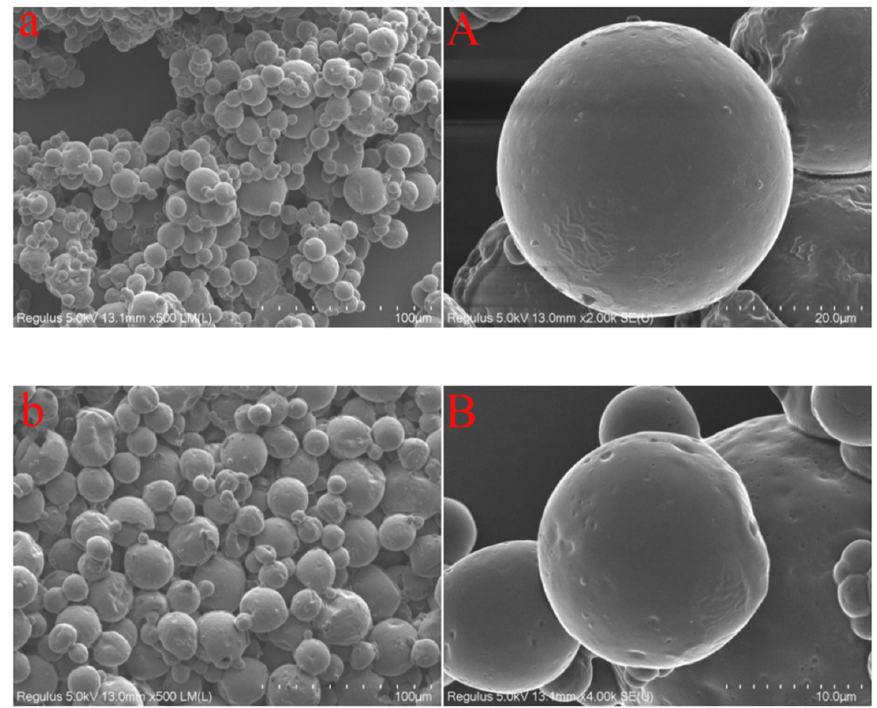
Figure 7. Microstructure of microcapsule of cannabis oil (( a , A ):SPI-SE; ( b,B ): WPI-SE). Table 3. Entrapment efficiency, surface oil content, moisture content and solubility of microencap- sulation. SPI-SE WPI-SE